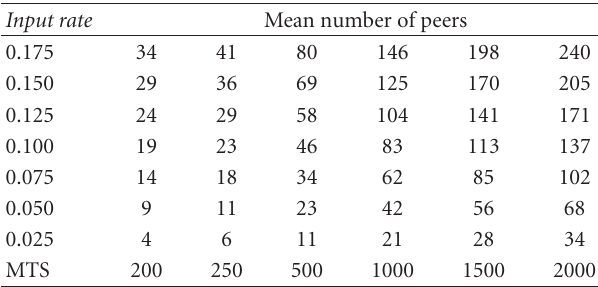
Table 2: Mean number of peers measured in the Fluidic